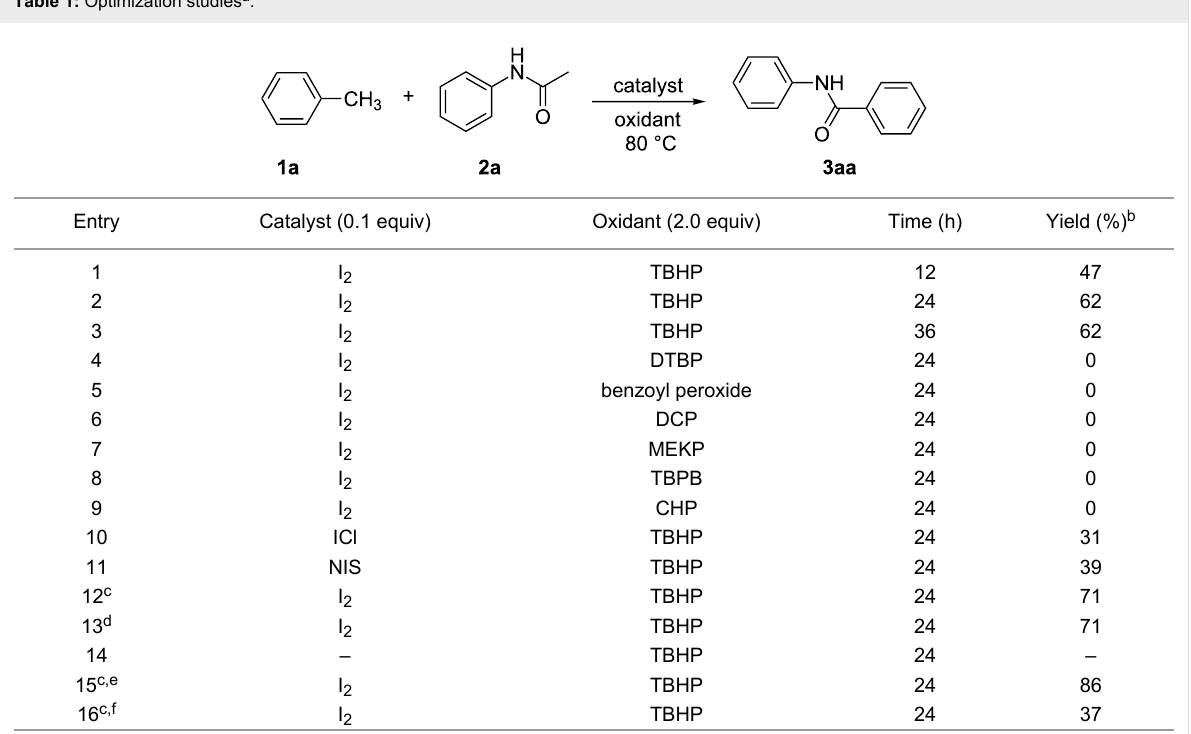
Table 1: Optimization studies a